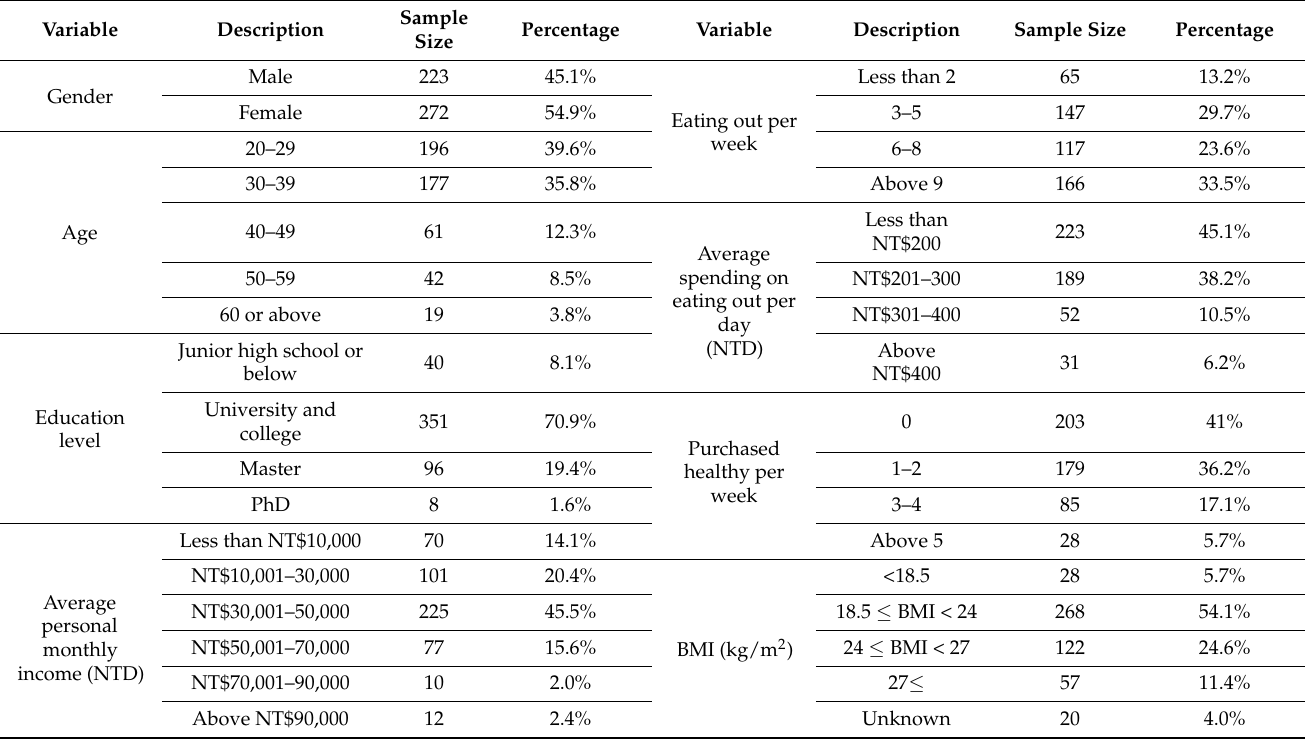
Table 2. Demographic